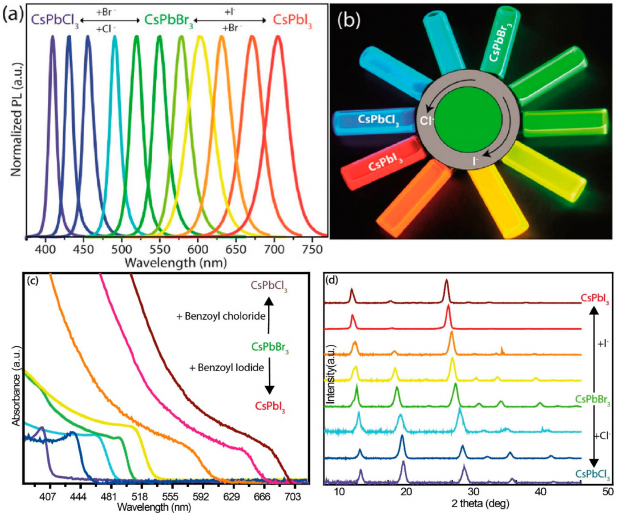
Figure 5. ( a ) Evolution of the PL spectra of CsPbBr 3 NCs by the addition of benzoyl chloride or benzoyl iodide. ( b ) Photograph of the different CsPbX 3 NC solutions obtained by anion exchange under an ultraviolet (UV) lamp. ( c ) Evolution of the absorbance spectra of representative anion-exchanged NCs. ( d ) XRD patterns of the pristine CsPbBr 3 NCs and the anion-exchanged samples, reproduced with permission from Ref. [17], Copyright (2018) American Chemical